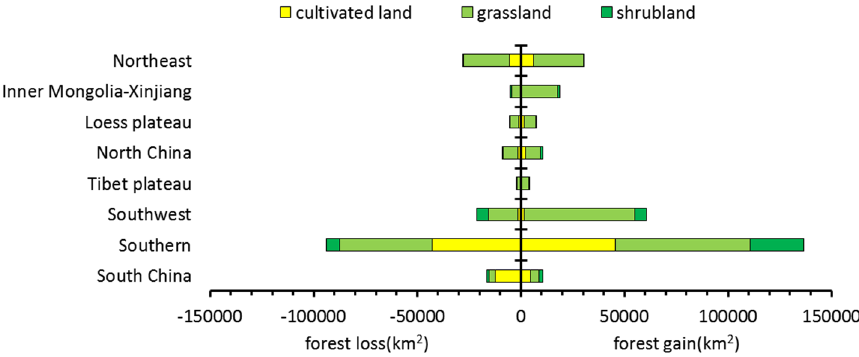
Figure 6. Transitions from forest to other land use types, 2000–2010.